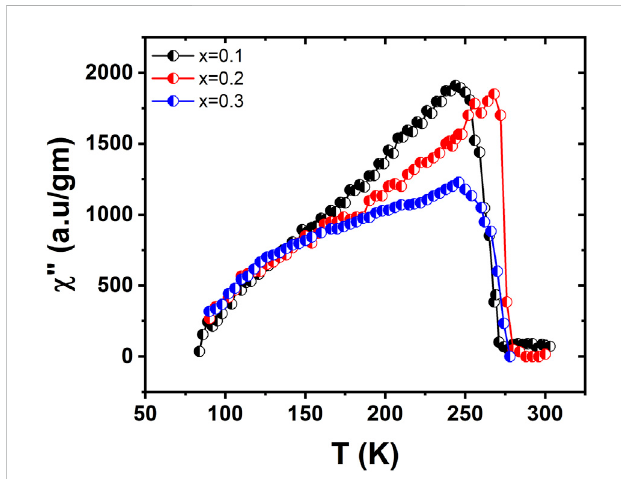
FIGURE 9 Variation of the out-of-phase part of ac susceptibility as a function of temperature for La 1-x Ca x MnO 3 (x = 0.1, 0.2, and 0.3) showing T c at different temperatures.